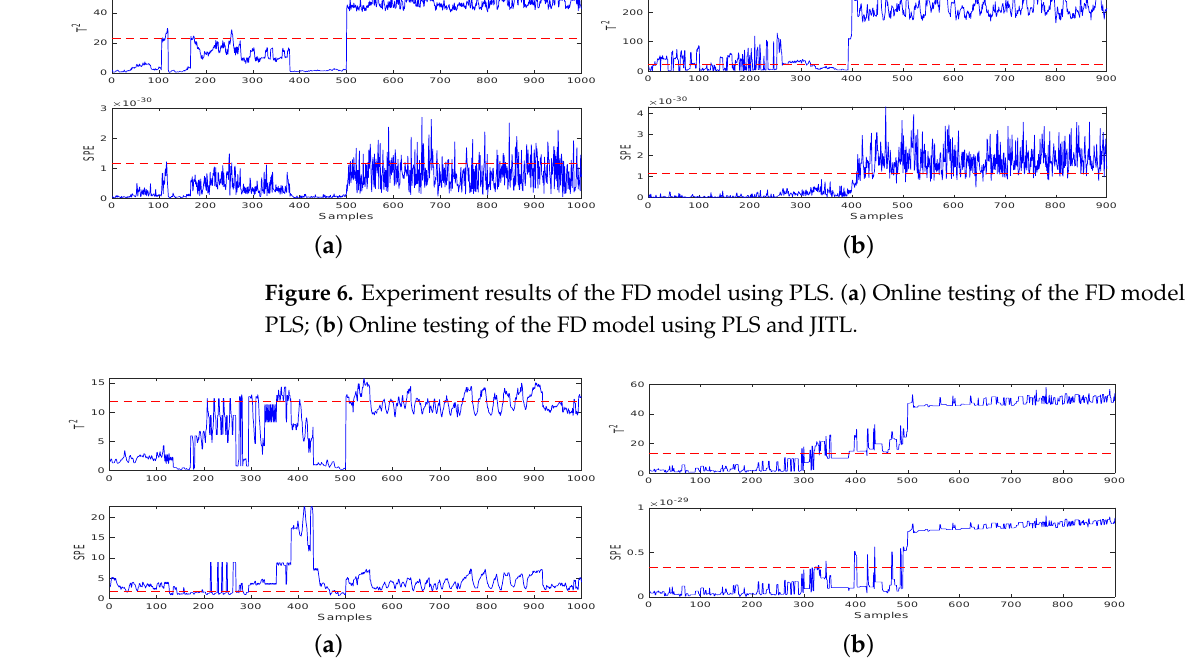
Figure 7. Experiment results of the FD model using PCA. ( a ) Online testing of the FD model using PCA; ( b ) Online testing of the FD model using PCA and